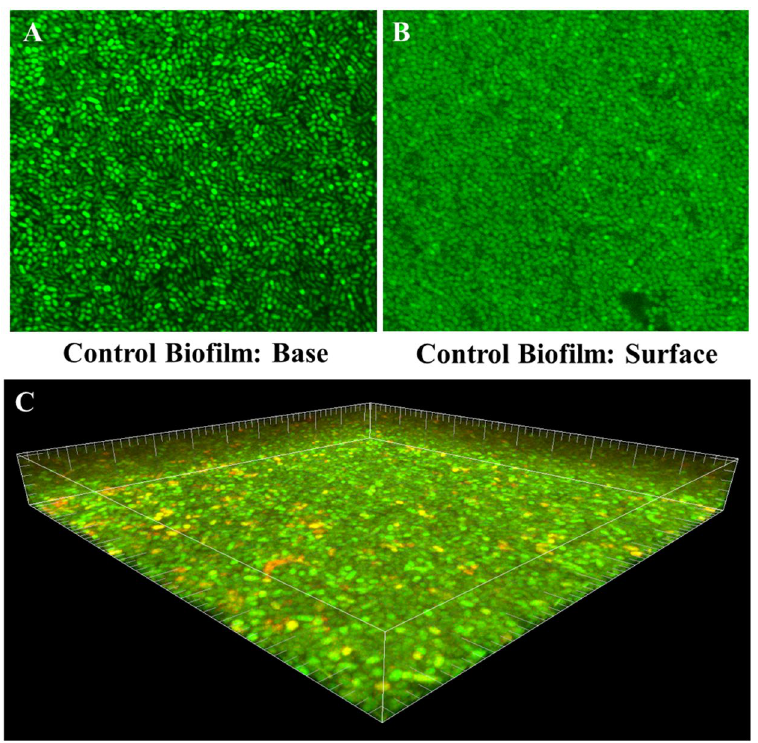
Figure 2. CLSM image of control biofilm. ( A ) Image of base of Biofilm, it shows base of biofilm dominated by rod shaped bacteria. ( B ) Surface of biofilm shows the dominance of coccid shaped bacteria. ( C ) 3D image of control biofilm.